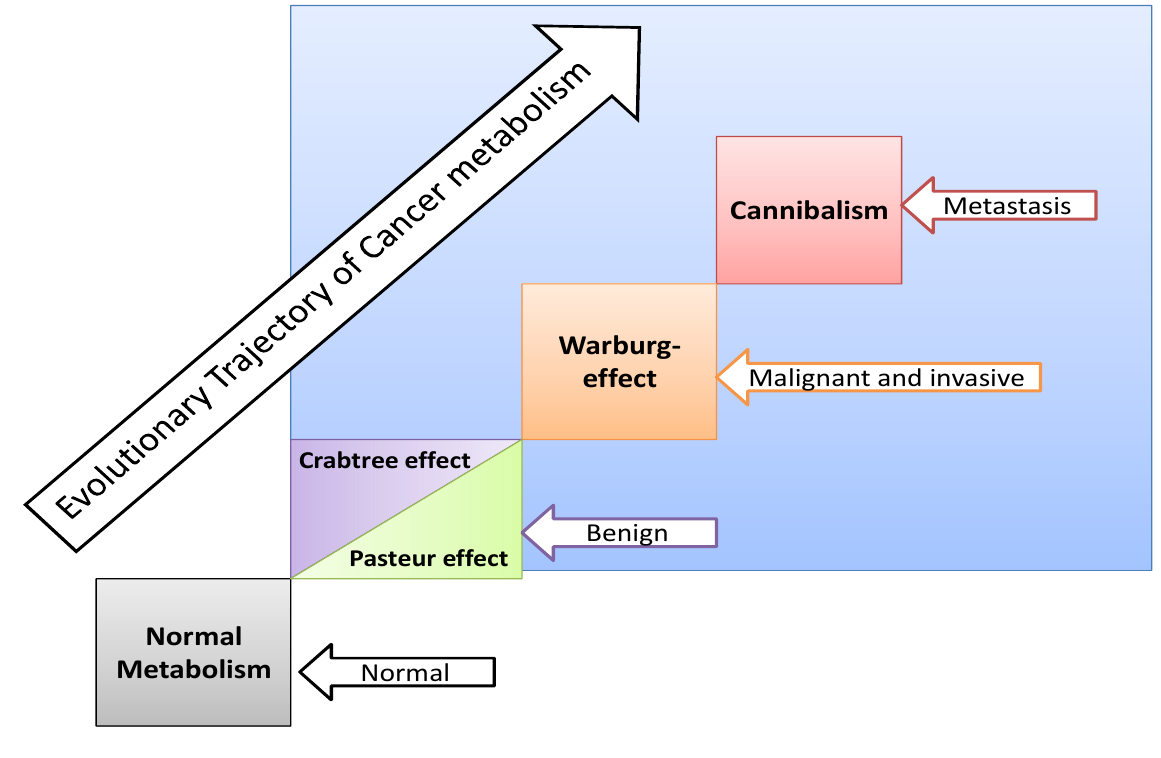
Figure 4. Hypothetical model describing carcinogenesis as a metabolic ladder (cascade). Bluish background represents tumor microenvironment which is the medium necessary for driving